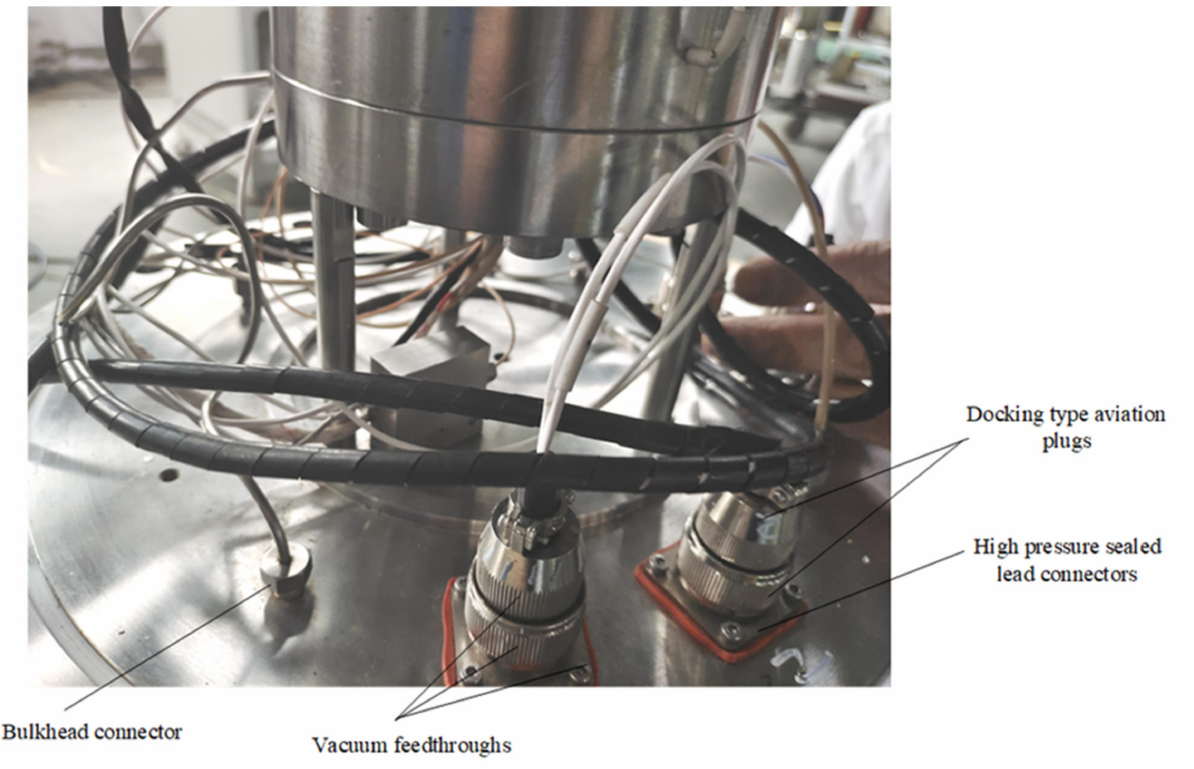
Figure 6. The bottom flange of the vacuum tank. The sapphire window in the top cover of the reactor is aligned with the sapphire window mounted inside the vacuum chamber lid, which also has a maximum visible diameter of 82 mm. Condensation on the outer window is prevented by purging its surface with continuous dry nitrogen gas through a purge port above the glass edge. A jacket is welded to the outside of the vacuum chamber for the flow of liquid nitrogen through